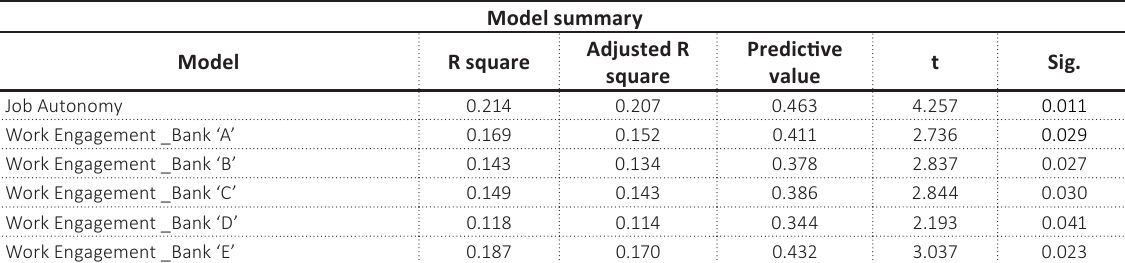
Table 3. Summary of regression job autonomy and employee work engagement Model